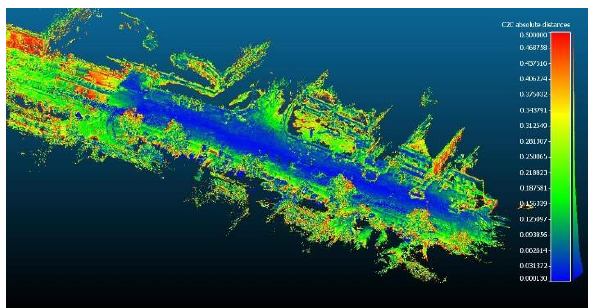
Figure 12. Comparison of point clouds between the real-time solution of the Stencil 2 and the photogrammetry model, related Via San Polo